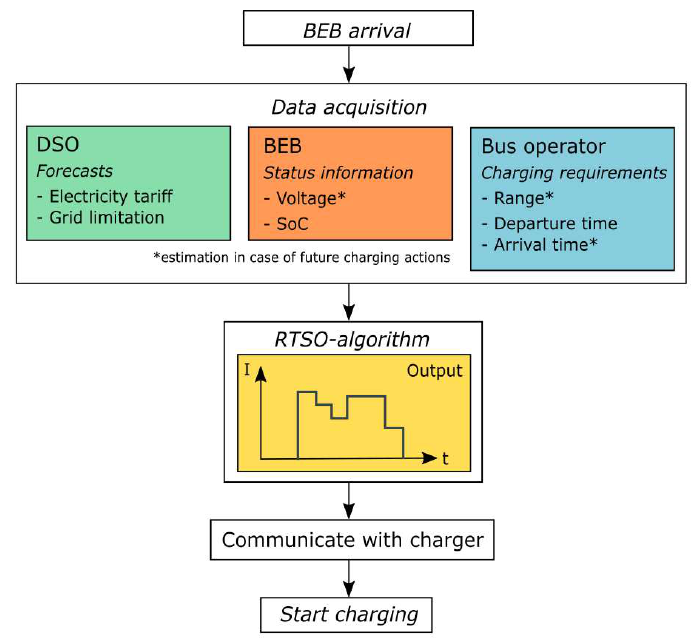
Figure 2. Flowchart of the real-time scheduling and optimization (RTSO) algorithm.